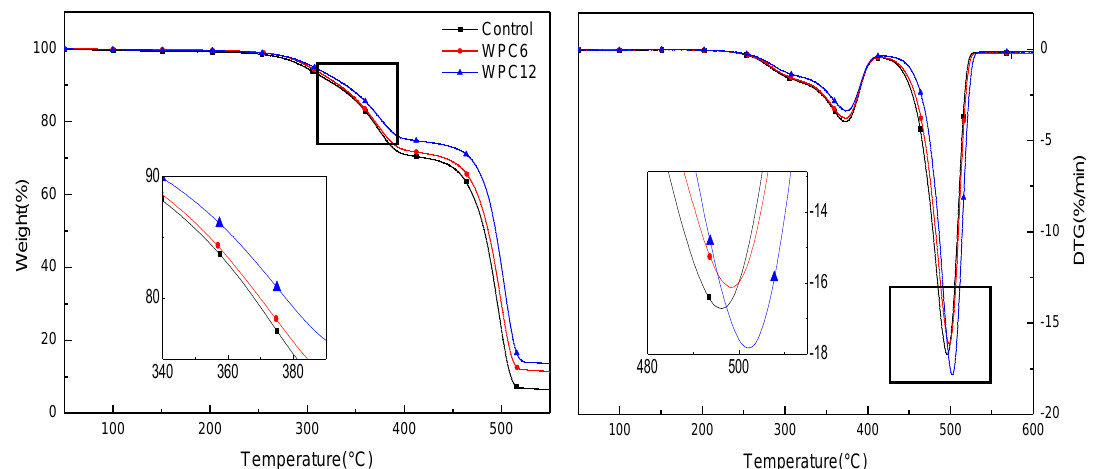
Figure 4. Mass loss curves and DTG curves of WPCs with added GNPs. Table 2. Thermal decomposition parameters for WPCs with added GNPs.